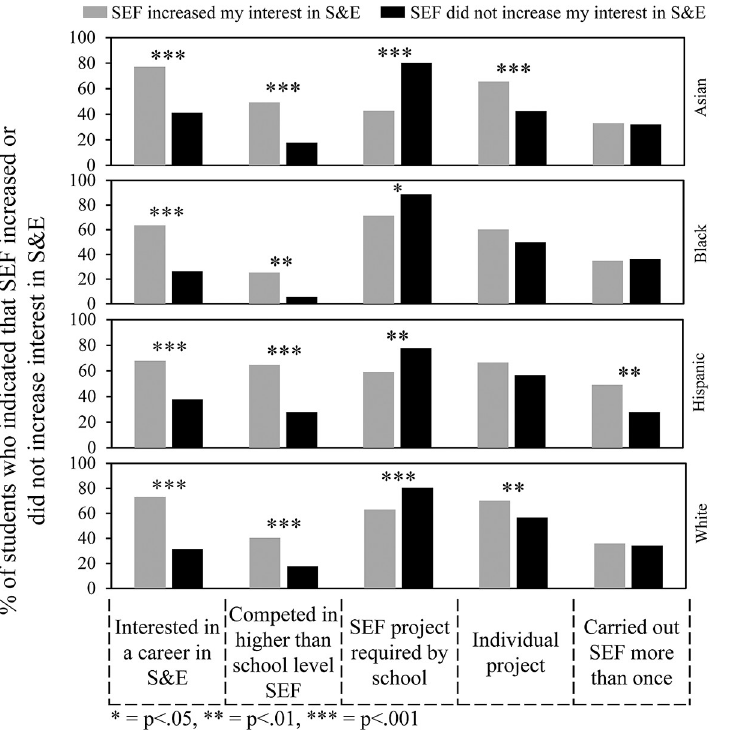
Fig 7. Overall features that influenced impact of SEF on student interest in